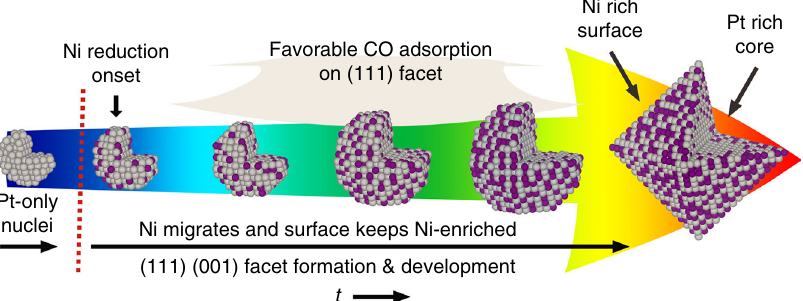
Fig. 5 Schematic octahedral Pt 3 Ni growth pathway. Scheme (not to scale) of octahedral Pt 3 Ni growth pathway with inner section view (gray: Pt; purple: Ni). The nuclei stage is only constructed to show a possible dynamical